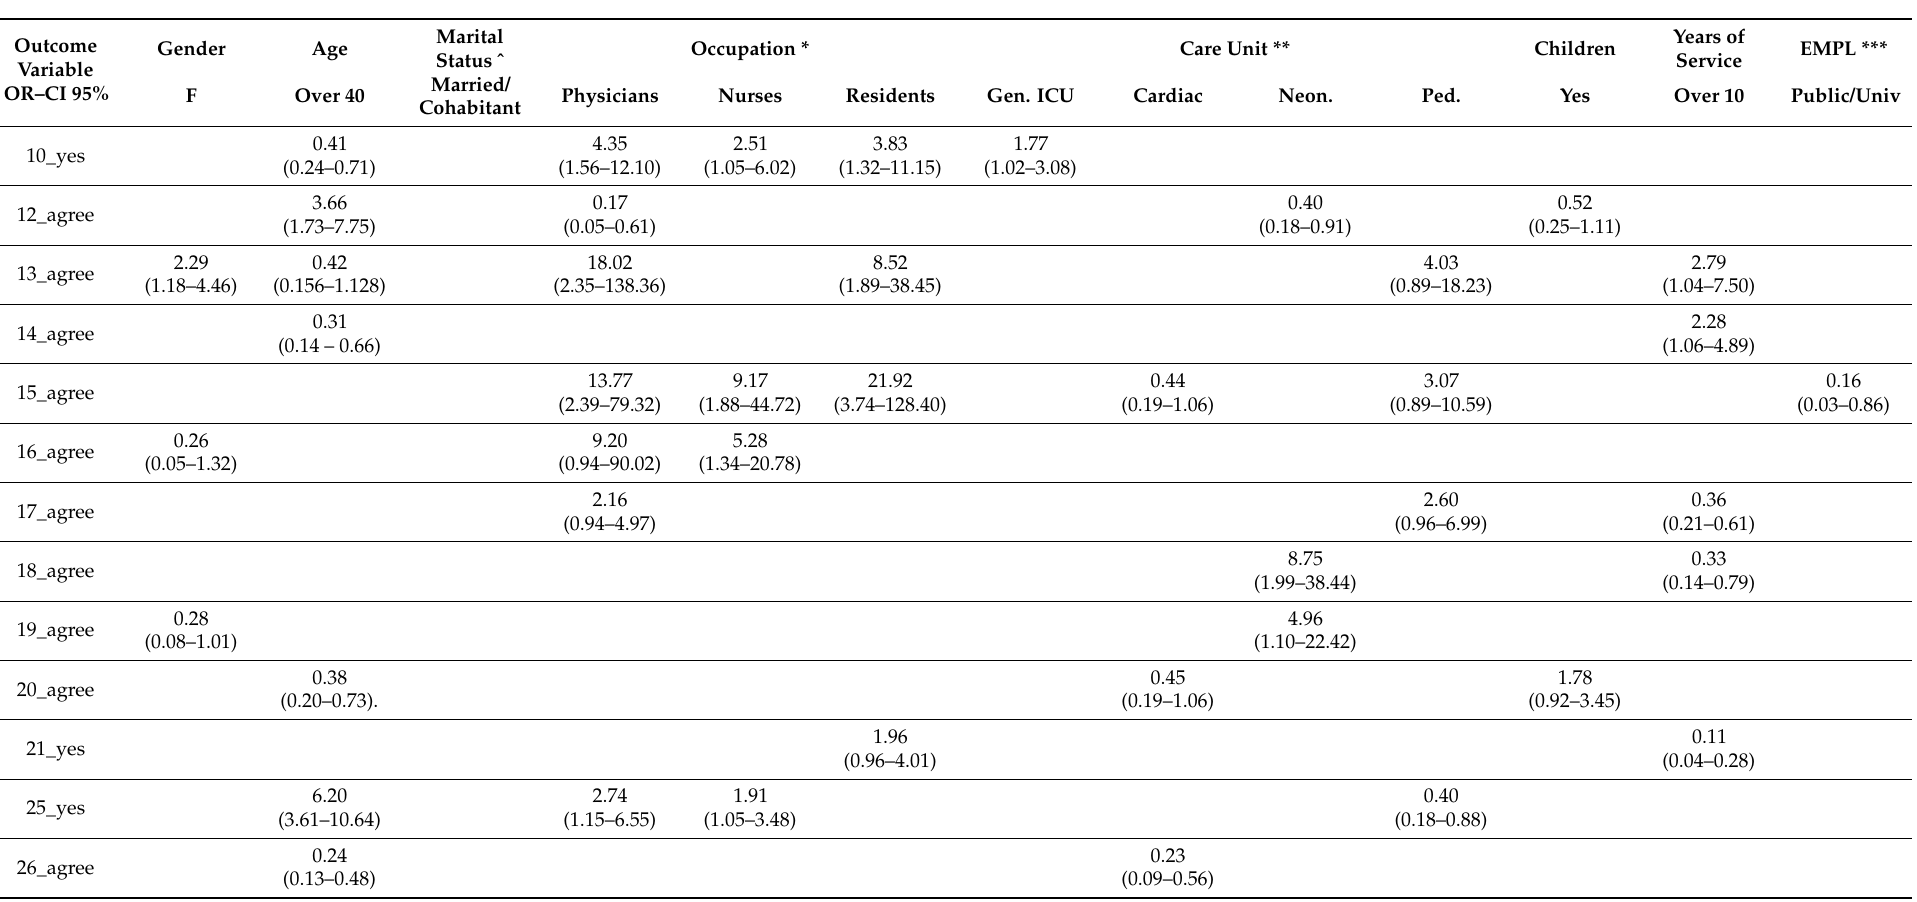
Table 2. Results of multivariate analysis—OR (95%CI) positive